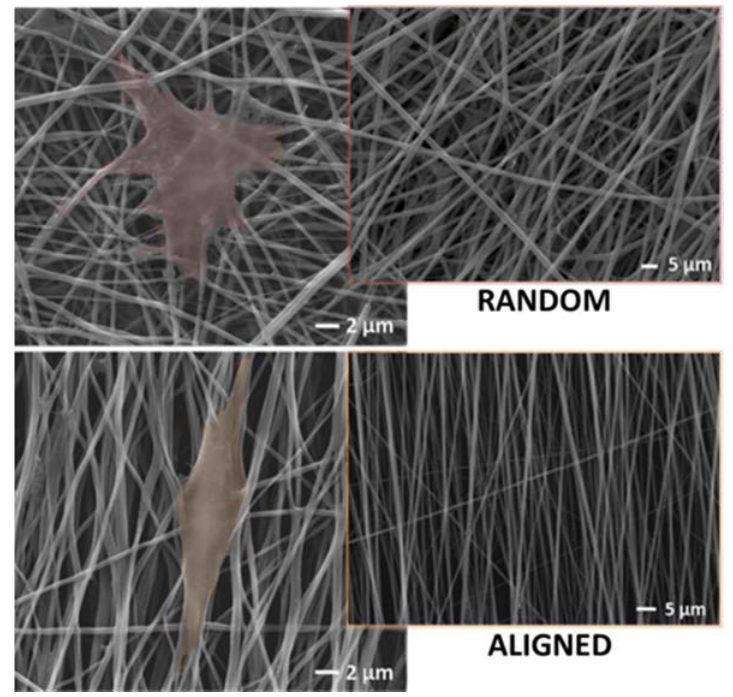
Figure 3. Bicomponent electrospun fibers fabricated by the combination of poly- ε -caprolactone and gelatin with random or aligned fibers organization (see into the square). Morphology of hMSC cell bodies influenced by the topological signals of the surrounding substrates. Image are adapted from V. Cirillo et al., J Mater Sci, Mater Med, 2014 [26].